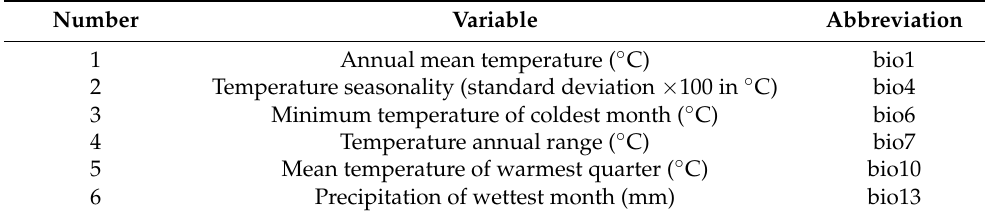
Table 1. Environmental variables used in the study. Table 2. The two future models used in the